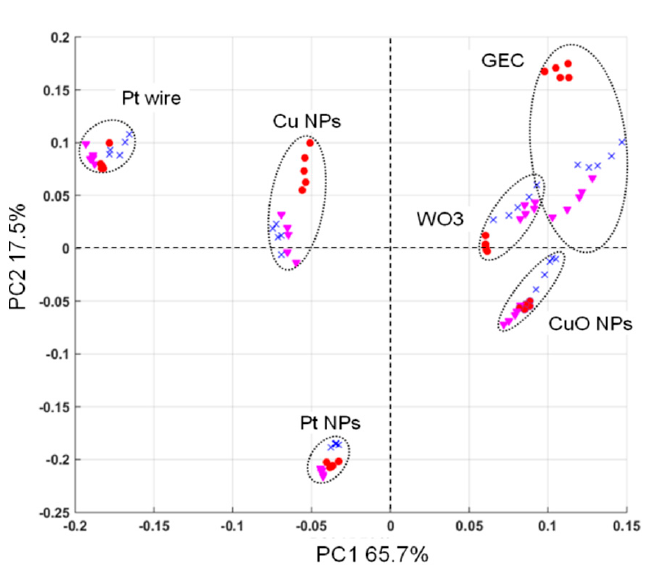
Figure 7. Score plot of the first two principal components obtained after PCA. Five replicates for each compound (concentration of 25 ppm) were measured with the six sensors in the ET array. Diazepam, (red circle); flunitrazepam (pink triangle), and lorazepam (blue cross).